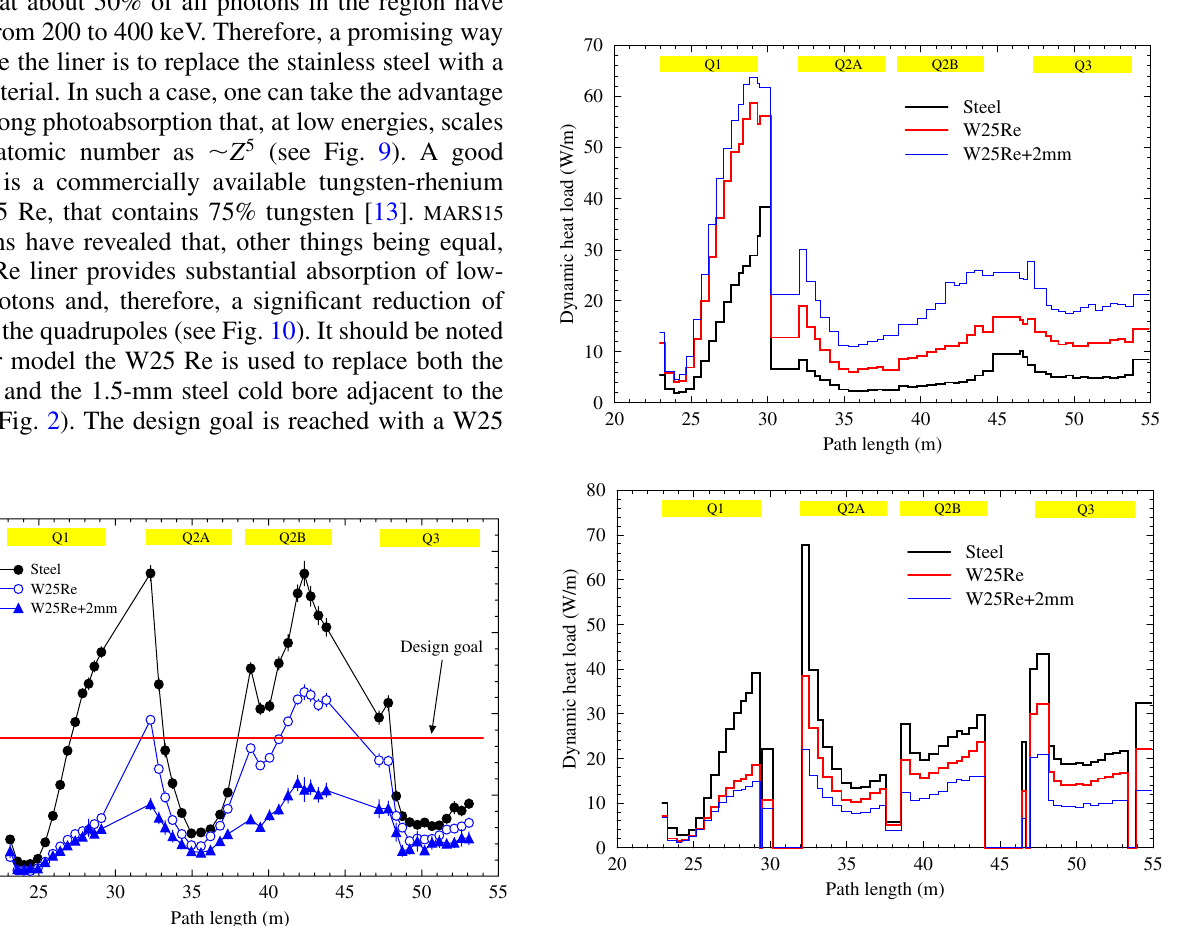
Sn quadrupoles 3